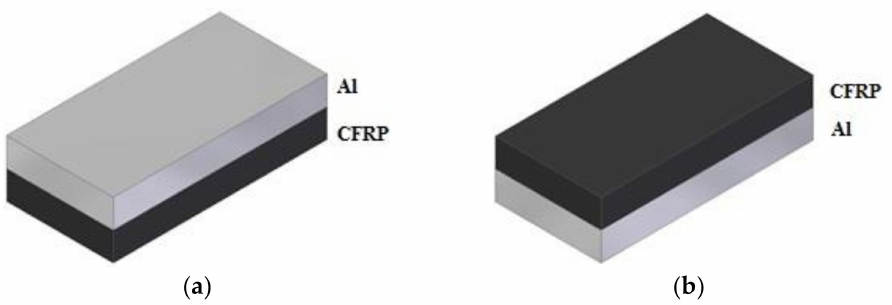
Figure 3. Considered milling strategies: ( a ) Al/CFRP, ( b )